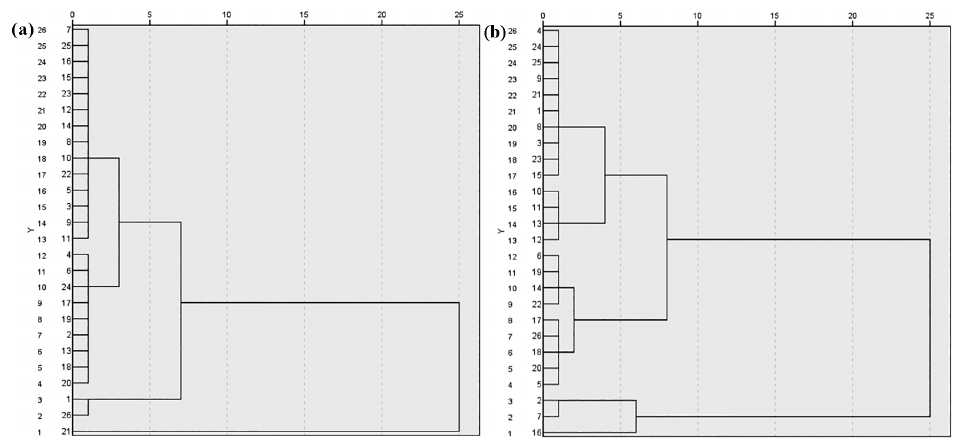
Figure 7. Cluster analysis of the zooplankton in the extreme water level fluctuation period ( a ) and the regular water level fluctuation period ( b ).